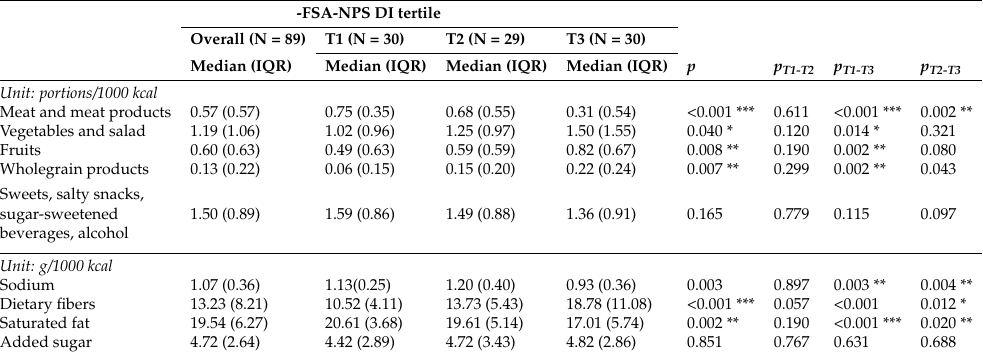
Table 9. Median and interquartile range (IQR) of the relative (i.e., per 1000 kcal of) nutritional intake across the tertiles of the inverted Food Standards Agency Nutrient Profiling System Dietary Index (-FSA-NPS DI) a . -FSA-NPS DI tertile Overall (N = 89) T1 (N = 30) Unit: portions/1000 kcal Meat and meat products 0.57